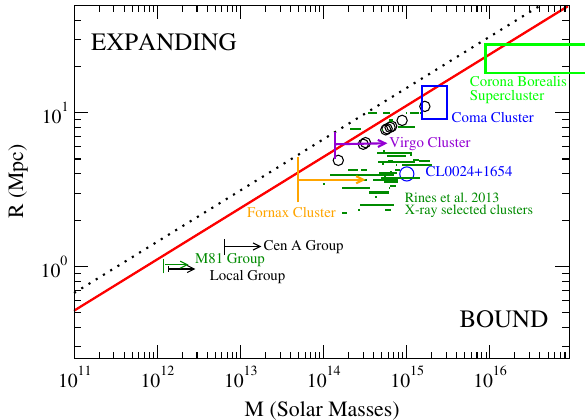
Fig. 1 Observed size versus mass plot for several nearby cosmic struc- tures compared to the R TA , max predicted by (cid:2) CDM ( red line ). The dotted line represents the maximum departure due to non-sphericities. (Taken from Ref. [4], © SISSA Medialab Srl. Reproduced by permis- sion of IOP Publishing. All rights